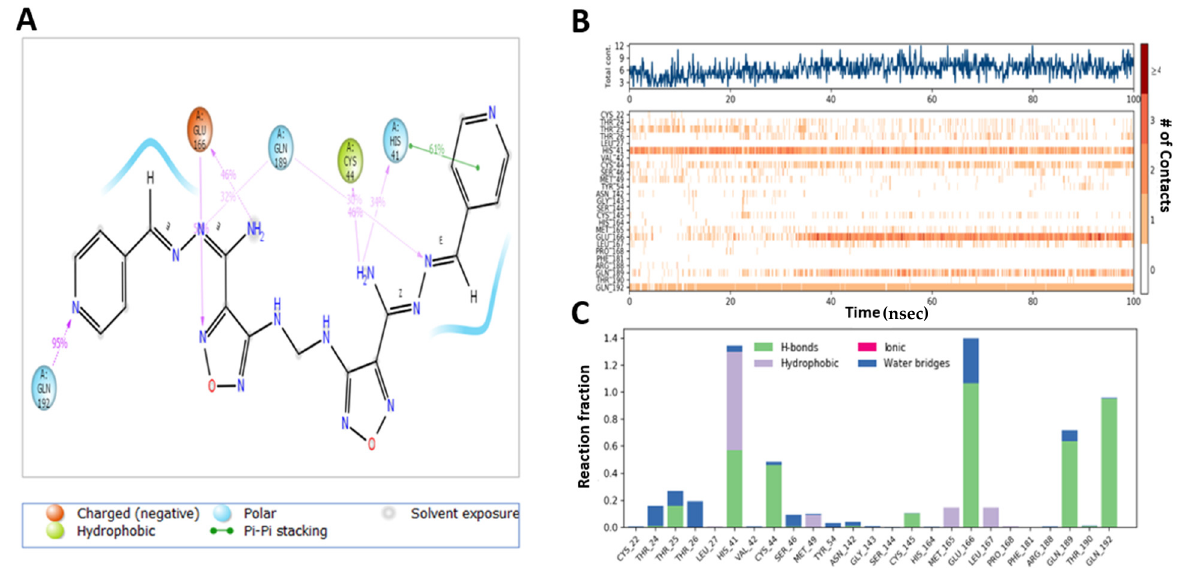
Figure 12. Interaction diagram of M3 with M pro observed during the molecular dynamic simulation. ( A ) The protein–ligand interaction diagram. ( B ) The top panel showed the specific contact of M pro protein with M3 in each trajectory course, the bottom panel showed the amino acid residues that interact with the ligand in the trajectory time frame. The residues making more than one contact were shown in a darker color shade. ( C ) Schematic diagram of ligand interaction with the amino acid residues of protein during MD simulation.